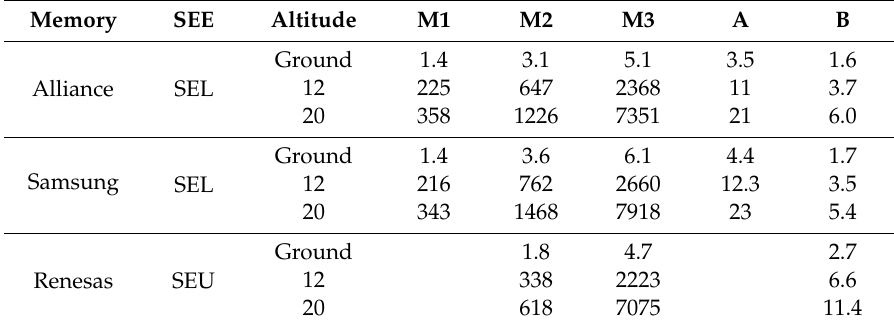
Table 4. Summary [FIT / device] from M1, M2, M3 due to the combined contribution of neutrons and protons, at ground level (Geneva, 375 m), 12 km and 20 km of altitude. A = M3 / M1, B = M3 / M2. Memory